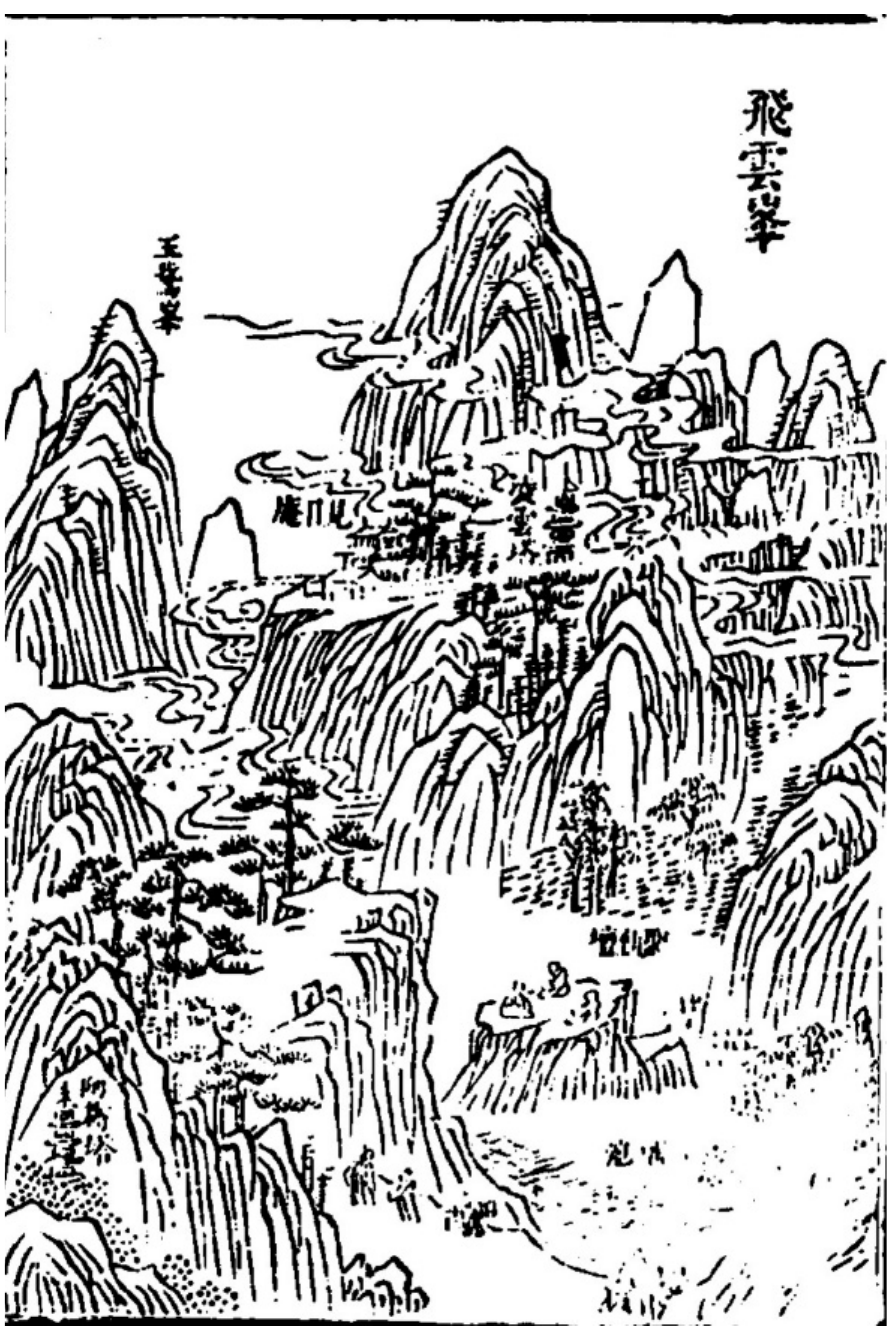
Figure 6. Image of the Feiyun Feng, 1639. Woodblock print. After Han Huang, Luofu yesheng , 2.2a